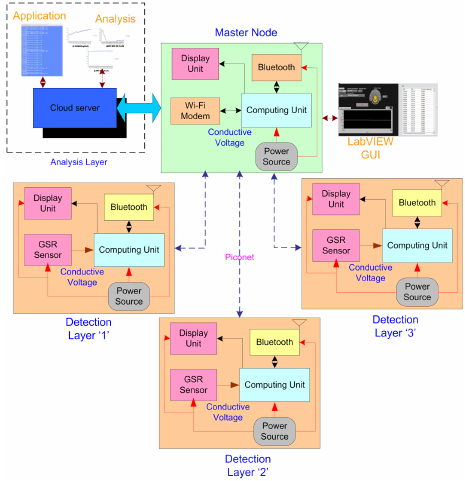
Figure 1. IoT-Enabled Stress Detector using